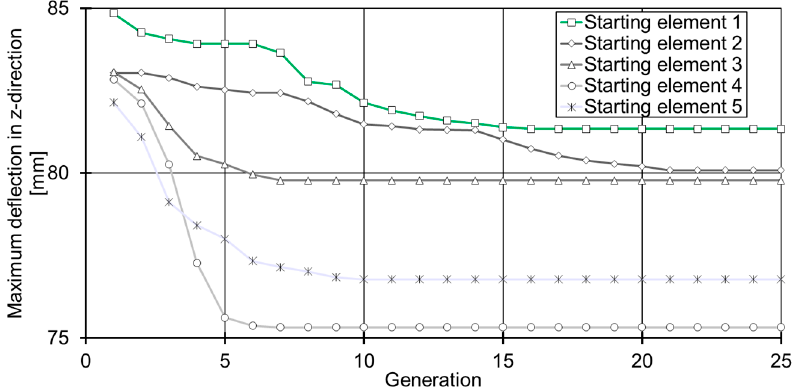
Figure 10. Convergence of objective function (maximum plate deflection in z-direction) during preform optimisation.